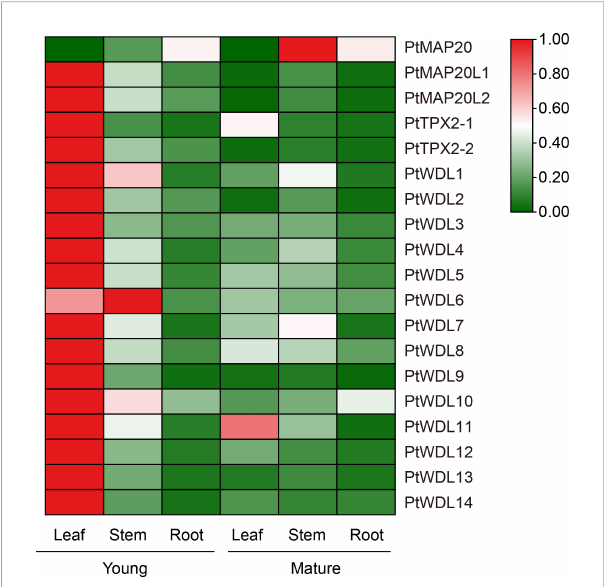
FIGURE 7 Heatmap of PtTPX2 gene expression patterns in different growing periods, young and mature. Green represents lower gene expression levels and red represents higher gene expression levels. The color represents the level of expression of each gene in each sample. The gene expression levels were calculated based on 2 − DD Ct